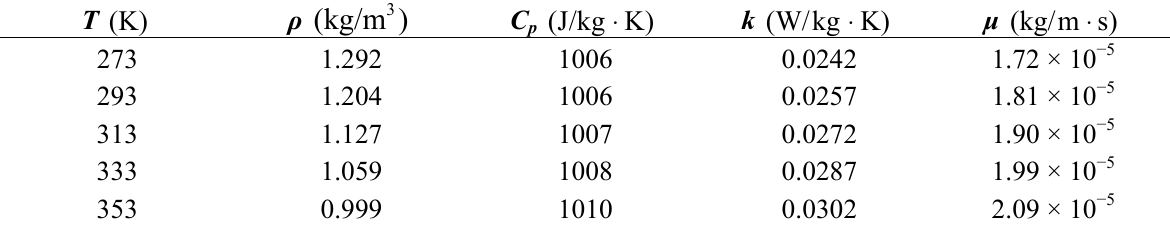
Table 1. Physical properties of air at 1 atm [3].